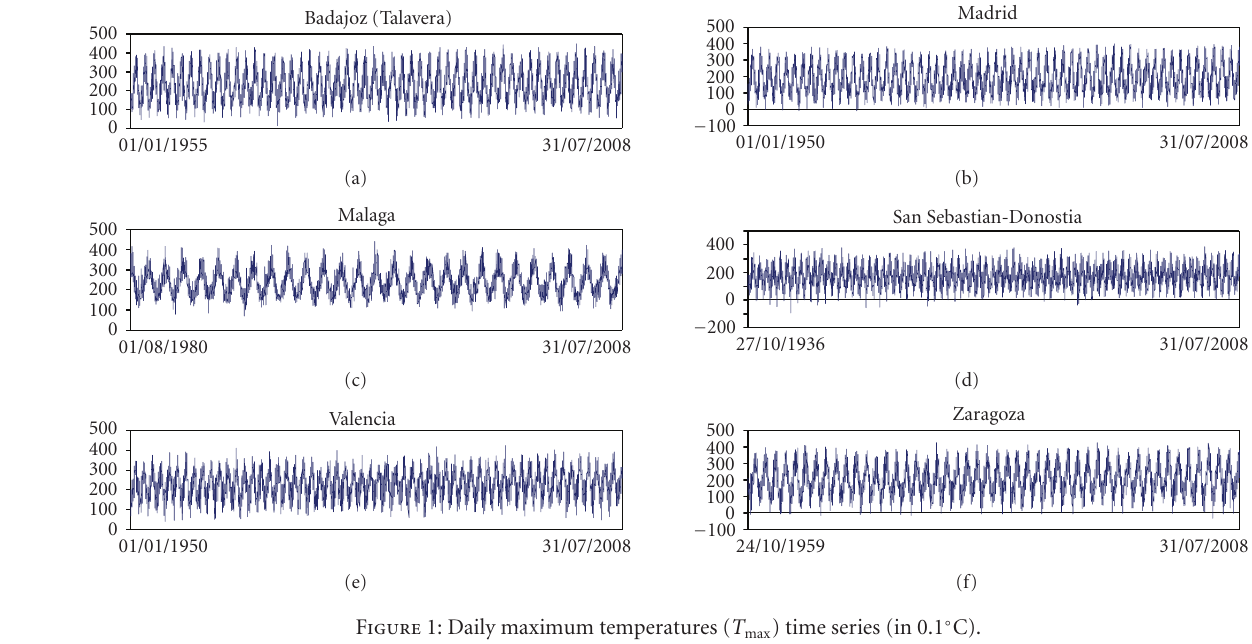
Figure 1: Daily maximum temperatures ( T max ) time series (in 0.1 ◦ C).